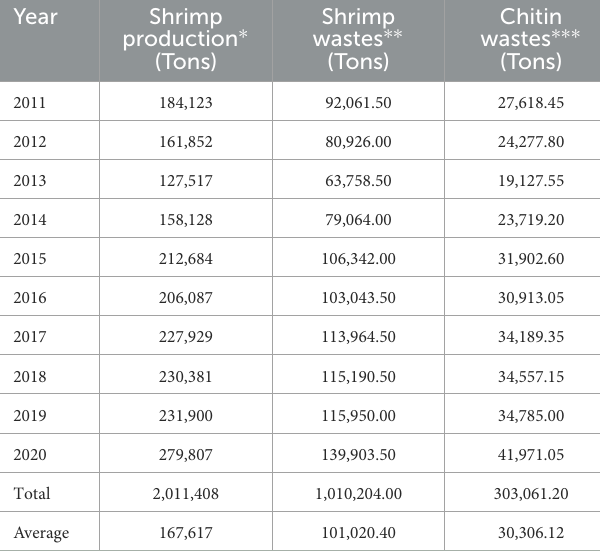
TABLE 1 Historical shrimp production on the Mexican coast and potential chitin